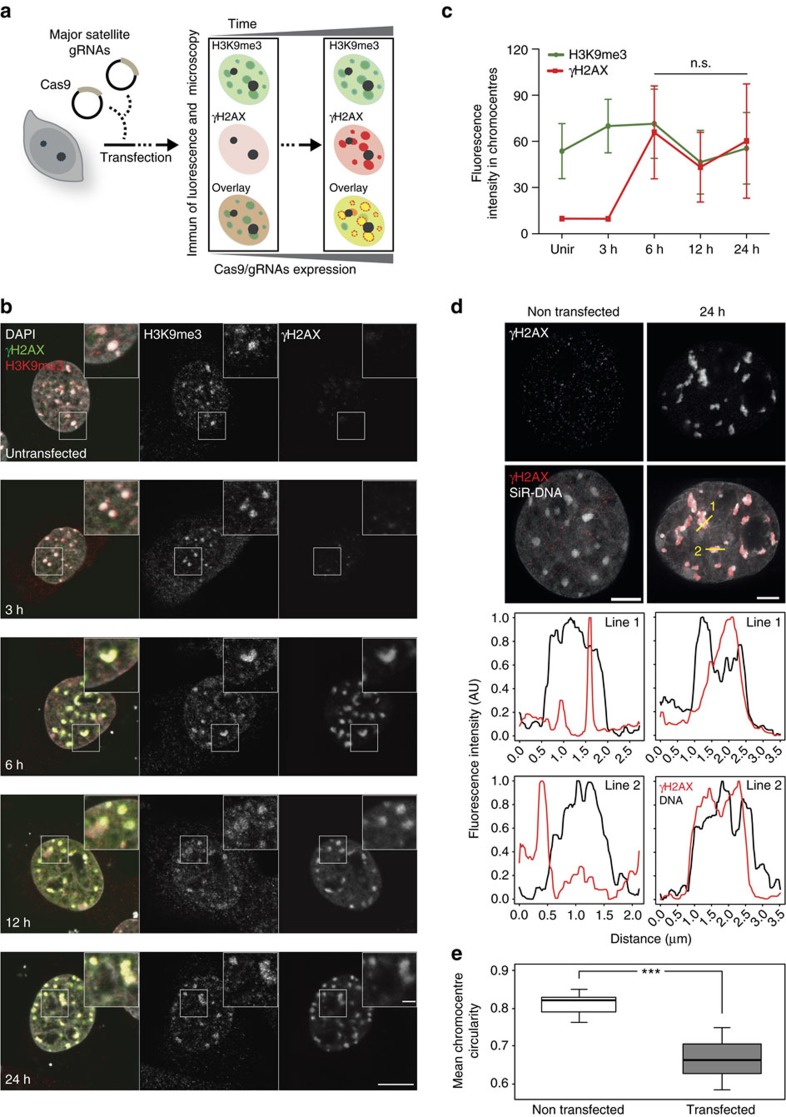
Analysis of γH2AX and H3K9me3 levels at heterochromatin-targeted CRISPR-Cas9-mediated DSBs.(a) Schematics of the CRISPR-Cas9-mediated DSBs induction at murine major satellites DNA. C2C12 cells were transfected with Cas9 and major satellites gRNAs plasmids and fixed after the indicated times. (b) Representative immunofluorescence images of γH2AX and H3K9me3 in C2C12 cells. Scale bars, 10 μm and 2 μm for micrograph and inset, respectively. (c) Quantification of γH2AX and H3K9me3 fluorescence intensity from DAPI-segmented chromocentres. Mean and s.d. from (b) are shown. n=5 cells (2–19 chromocentres), 5 cells (6–15 chromocentres), 5 cells (8–19 chromocentres), 5 cells (13–19 chromocentres) and 4 cells (9–19 chromocentres), for untransfected, 3 h, 6 h, 12 h and 24 h time points, respectively. See image analysis in the ‘Methods' section for details. (d) Representative STED immunofluorescence images of γH2AX and SiR-labelled DNA as indicated. Yellow lines: line profiles (shown below). For the latter, fluorescence intensities were normalized to the min–max range of values of each profile. Lines were smoothed by a 5-window running median. (e) Chromocentres decondensation after major satellite-targeted Cas9, assessed as mean chromocentre circularity in transfected (n=9) and untransfected (n=10) cells. For each cell, the circularity of chromocentres (>100 px2) within the nucleus was determined as described in the ‘Methods' section, yielding shape information for 165 (transfected cells) and 148 (untransfected cells) chromocentres. Statistics: Wilcoxon rank sum test (***P<10−3). Scale bar, 2 μm.